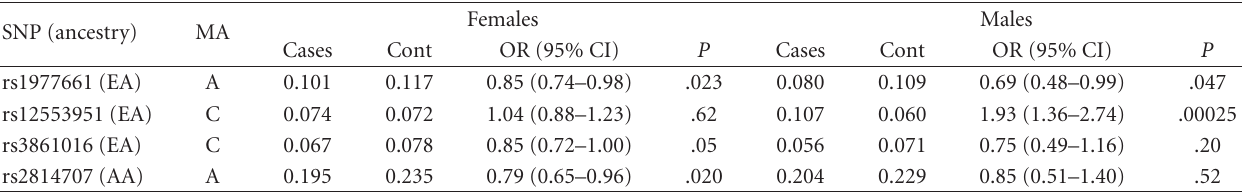
Table 4: SNPs in the IFNK locus which demonstrate evidence for association with SLE following stratification by sex in each ancestral